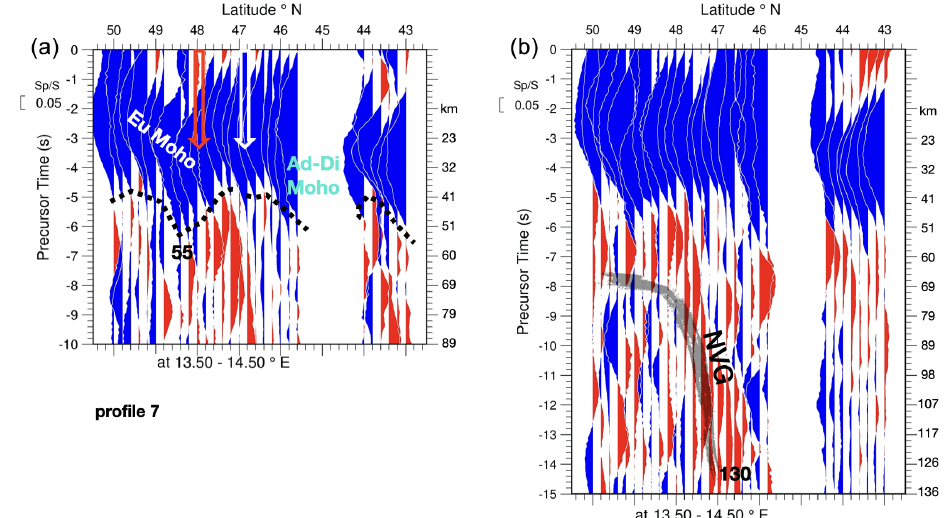
Figure 9. Profile 7. North–south profiles at 13.5–14.5 ◦ E, located easterly adjacent to the Tauern Window. “Ad-Di Moho” indicates Adriatic– Dinarides Moho. (a) The white arrow located near 47 ◦ indicates where the Moho reached the deepest point in profile 6 in Fig. 8. Note the abrupt along-strike change in terms of the Moho topography near 13 ◦ E longitude, where this section shows the exact opposite, namely a culmination rather than a trough at this same latitude near 47 ◦ (compare with Fig. 8). This location coincides with the white area in the map of Spada et al. (2013) denoting an area where the Moho is ill constrained by their data. The red arrow indicates the location of the frontal thrust of the Alpine orogen. (b) NVG denotes the location of one of the clearest NVG observations in the N–S profiles and the E–W profiles (see Fig. 12b).